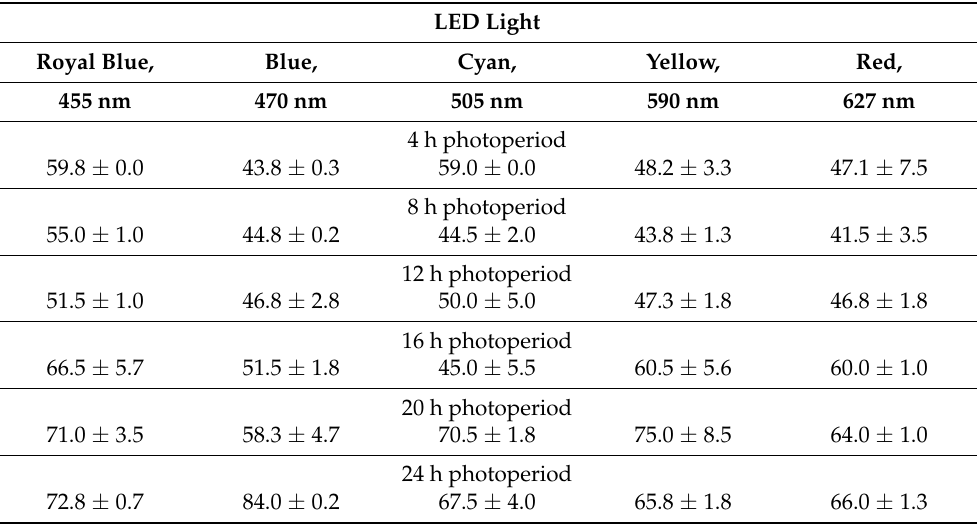
Table 4. The average recovery of the Botrytis cinerea growth rate after illumination by various LED light wavelengths and photoperiods. LED Light Royal Blue, Blue, Cyan, Yellow, Red, 455 nm 470 nm 505 nm 590 nm 627 nm 4 h photoperiod 59.8 ± 0.0 43.8 ± 0.3 59.0 ± 0.0 48.2 ± 3.3 47.1 ± 7.5 8 h photoperiod 55.0 ± 1.0 44.8 ± 0.2 44.5 ± 2.0 43.8 ± 1.3 41.5 ± 3.5 12 h photoperiod 51.5 ± 1.0 46.8 ± 2.8 50.0 ± 5.0 47.3 ± 1.8 46.8 ± 1.8 16 h photoperiod 66.5 ± 5.7 51.5 ± 1.8 45.0 ± 5.5 60.5 ± 5.6 60.0 ± 1.0 20 h photoperiod 71.0 ± 3.5 58.3 ± 4.7 70.5 ± 1.8 75.0 ± 8.5 64.0 ± 1.0 24 h photoperiod 72.8 ± 0.7 84.0 ± 0.2 67.5 ± 4.0 65.8 ± 1.8 66.0 ±